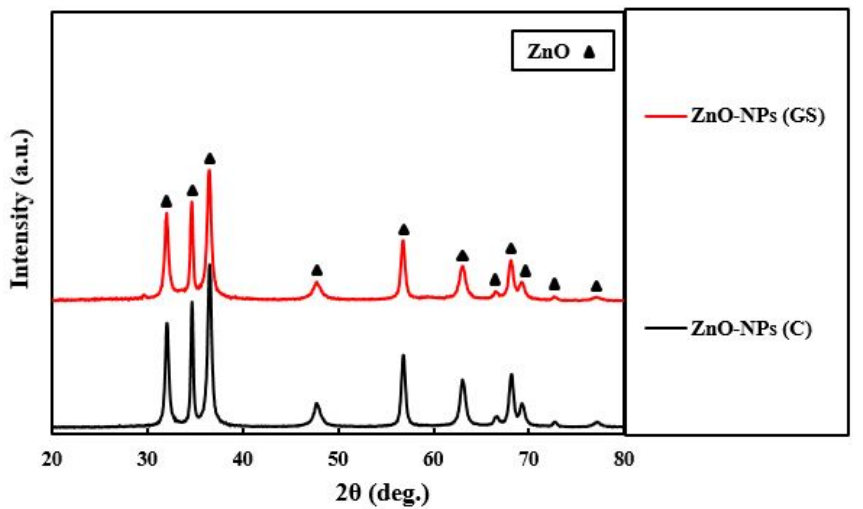
Figure 1. X-ray powder diffraction (XRD) patterns of commercial (C) and green synthesized (GS) ZnO-NPs.